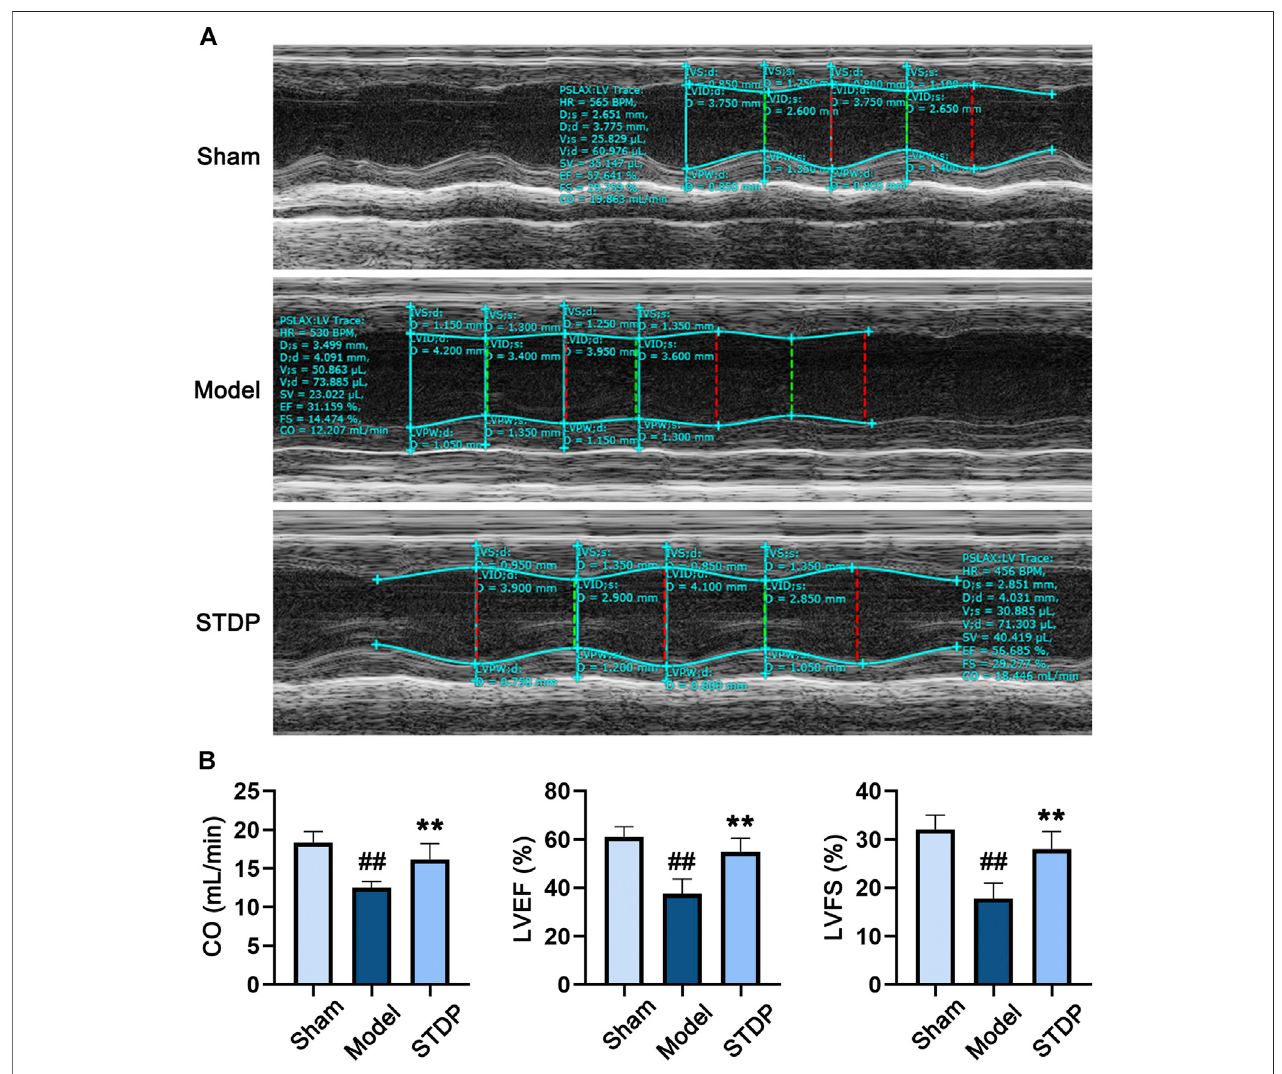
FIGURE1| STDPrelievesTAC-inducedcardiacdysfunctioninCHFmice. (A) Representativeechocardiogramsafter6 weeksofSTDPtreatment(86 mg/kg/d). (B) The cardiac function indexes of mice were quanti fi ed by the Vevo 1100 software. ## p < 0.01 versus the Sham group; ** p < 0.01 versus the Model group; n (cid:1)